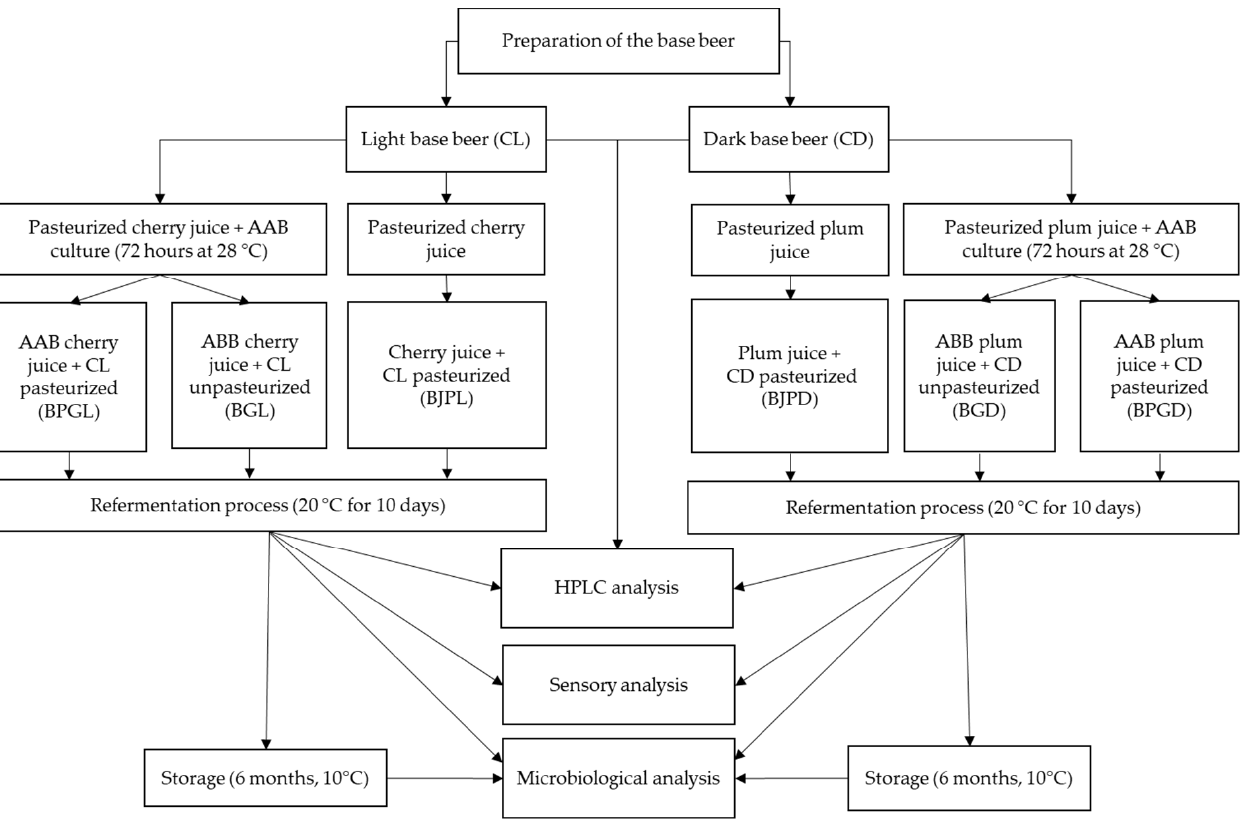
Figure 1. Experiment scheme. Table 1. Variants of study beer beverages and their composition.